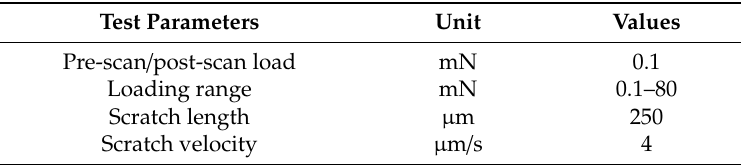
Table 1. Scratch test parameters.